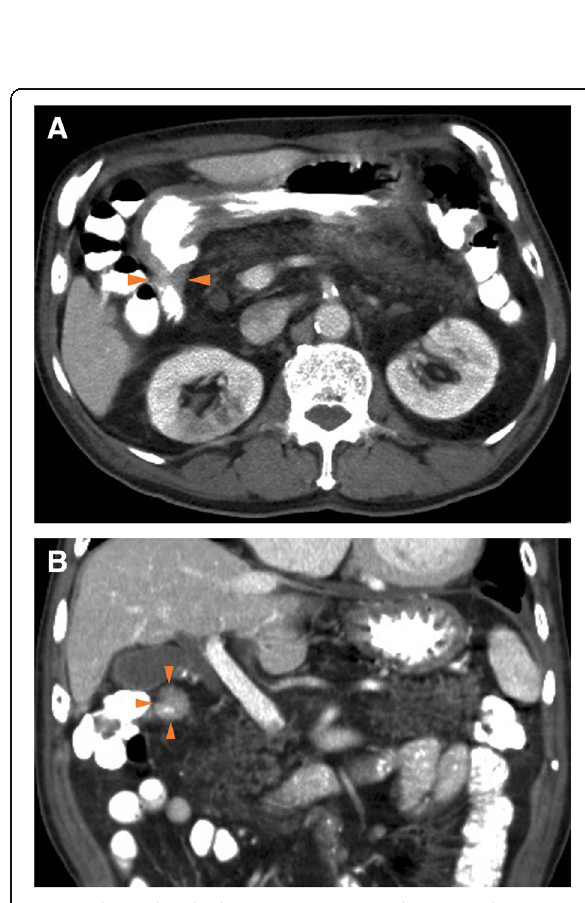
Fig. 2 Enhanced multi-detector row computed tomography (MDCT) image showing the wall thickness in the duodenum in the transverse ( a ) and the coronal ( b ) planes. Arrow heads: wall thickness of the first part of the duodenum Fig. 3 Schema of the operative findings. LN, Lymph node; T,